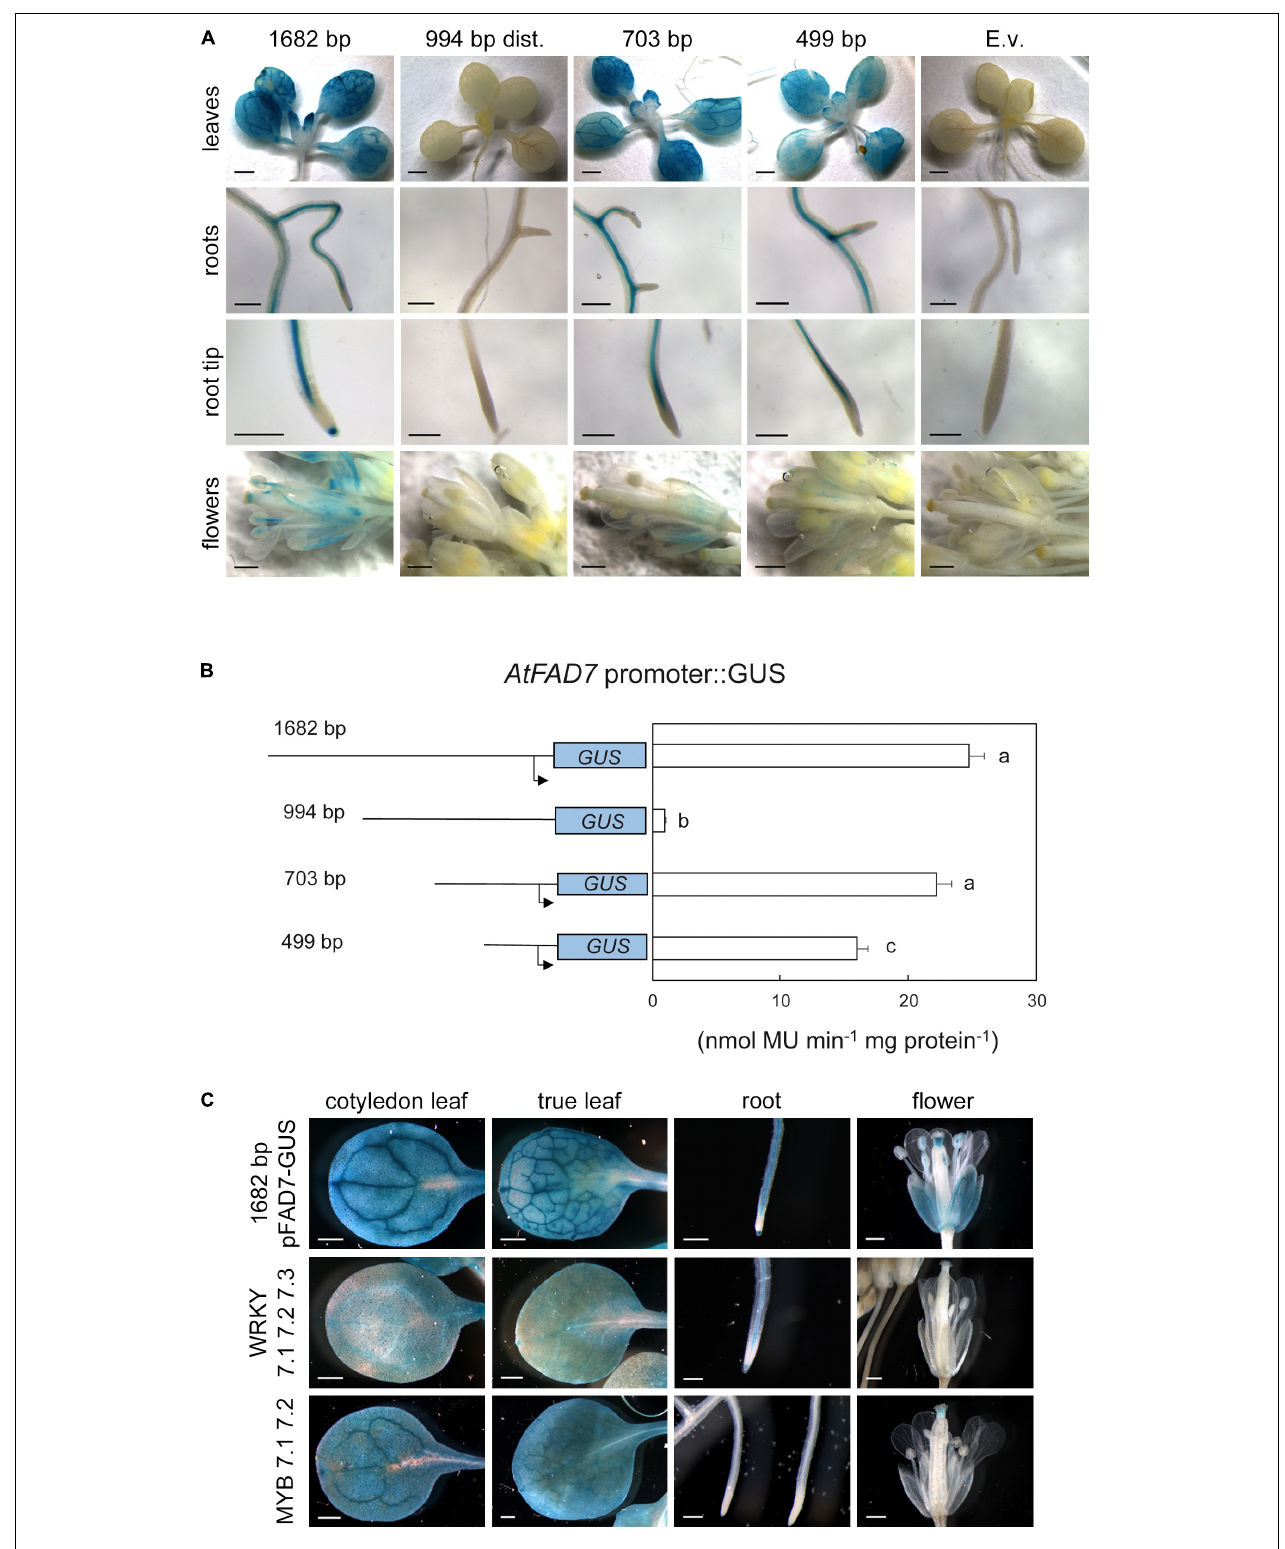
FIGURE 1 | GUS histochemical localization of the AtFAD7 gene promoter. (A) AtFAD7 promoter:GUS staining in leaves, roots and flowers. Results are shown for the control AtFAD7 1,682 bp fragment and the three deletions of 994 bp, 703 bp, and 499 bp, respectively. E.v. shows results obtained with the empty vector.